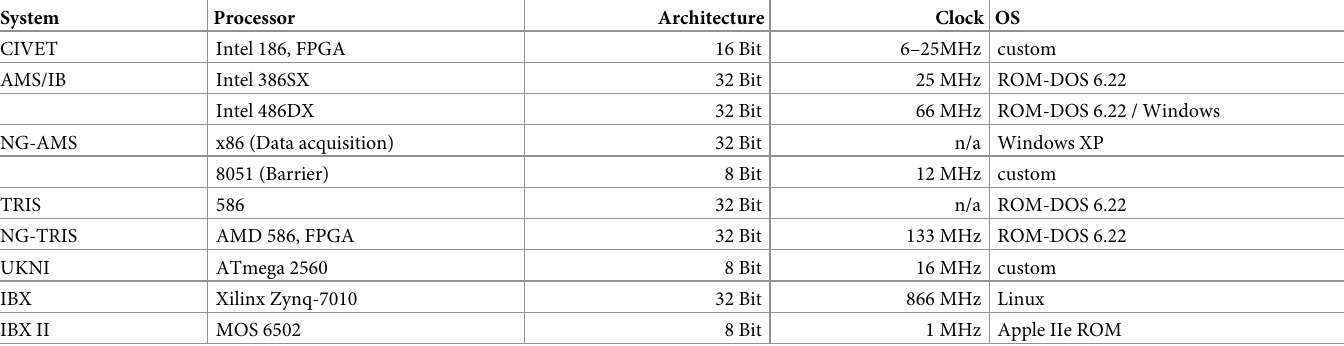
Table 1. Data processing parts of different information barrier